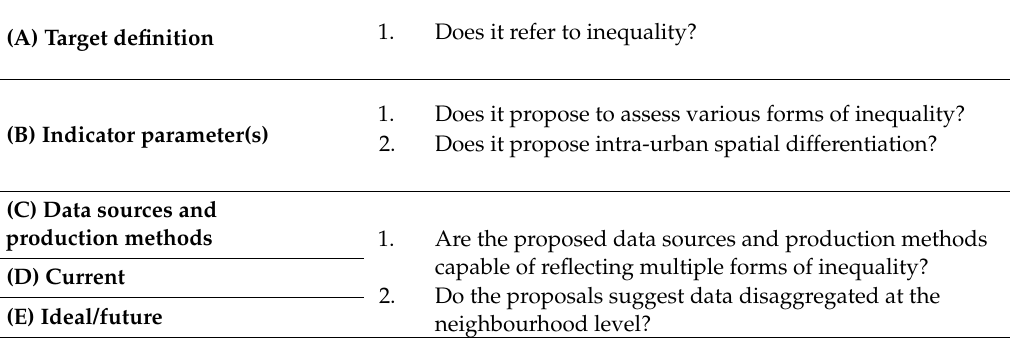
Table 2. The operationalised methodological approach for this